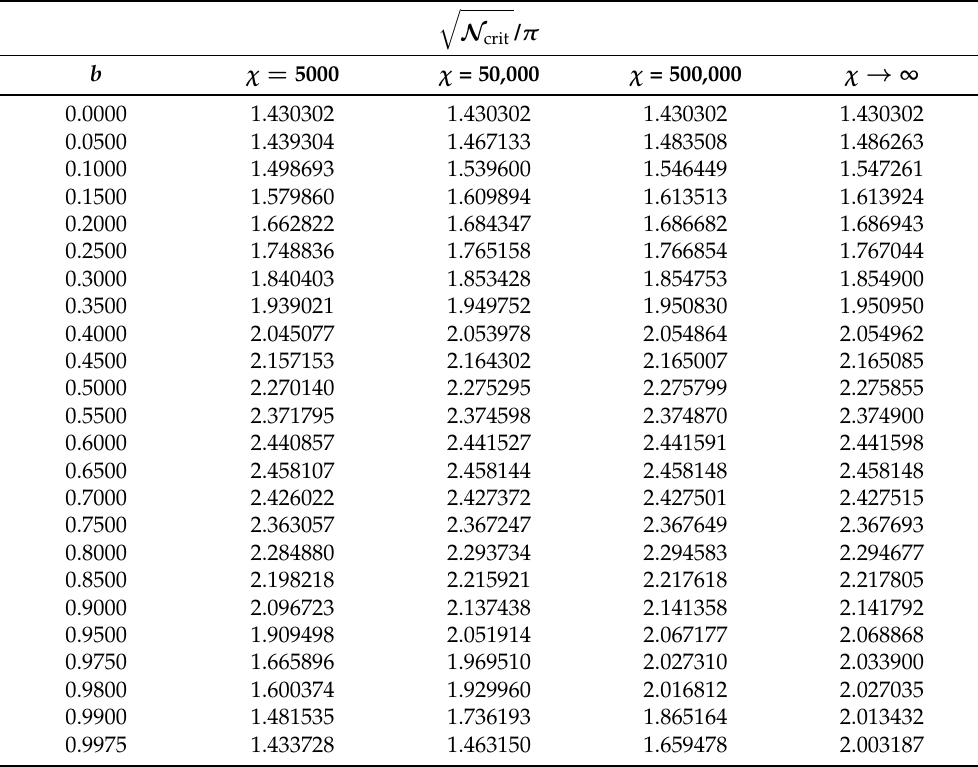
Table 6. The critical forces of FssP beams if χ = 5000, ..., 500,000 and χ → ∞ .